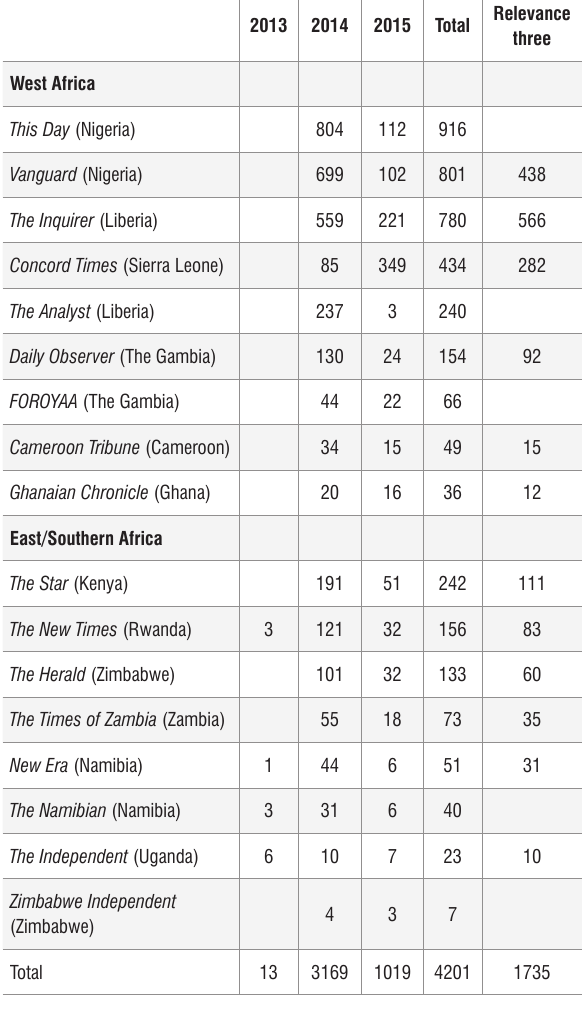
Newspaper and frequency of occurrence of the keyword ‘Ebola’ 2013 2014